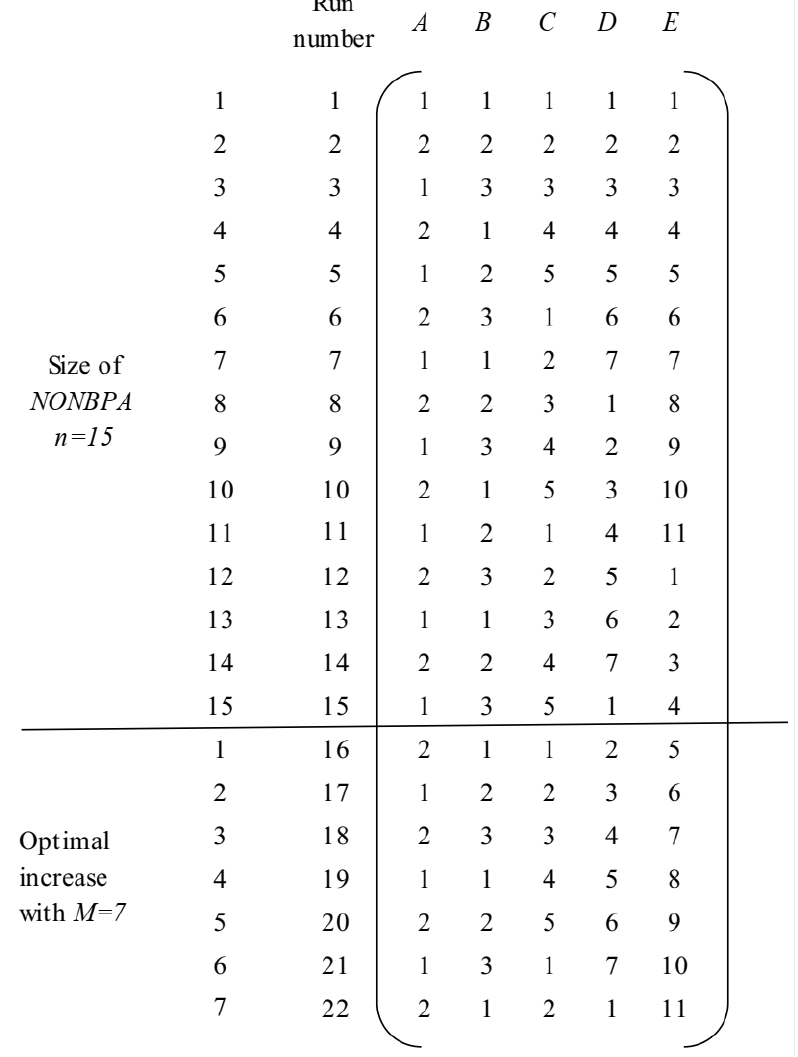
Figure 7. NONBPA (15,2 1 3 1 5 1 7 1 11 1 ) augmented with 7 runs. Table 5. Properties NONBPA (15,5 1 6 1 7 1 ) vs. NONBPA augmented (21,5 1 6 1 7 1 ).